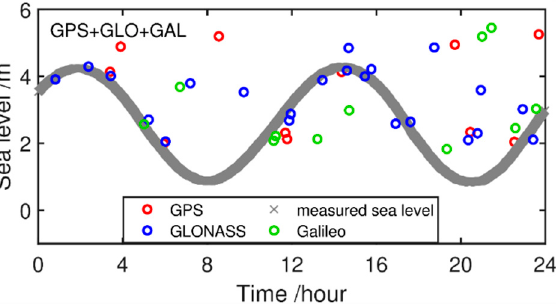
Figure 7. Absolute SSH series retrieved from the peak RHs at site SCOA are compared with meas- urements of the tide gauge on DOY 1,